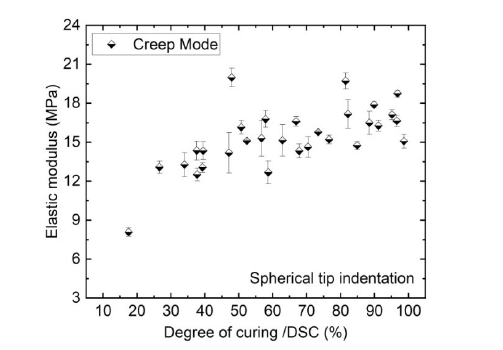
Figure 12. Data of elastic creep modulus (calculated from the creep curves) of the EVA surface as a function of 30 different DoCs as measured by